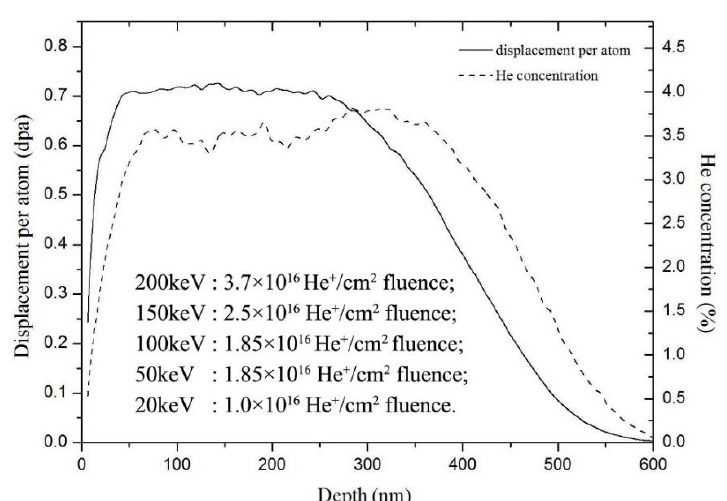
Figure 1. Depth profile of displacement damage and helium concentration in polycrystalline tungsten irradiated by He + ions from 200–20 keV energy with corresponding ion fluence calculated by SRIM 2008 software with quick mode. The atom displacement threshold energy ( E d ) of tungsten is 90 eV. The helium ions with 200 keV were first used to irradiate the samples. And then ion energy was degraded until 20 keV. According to the simulation results of SRIM 2008 software (SRIM.EXE, (C) 1984–2013, James F. Ziegler, Annapolis, MD, USA) with quick mode, the helium-ion irradiation with